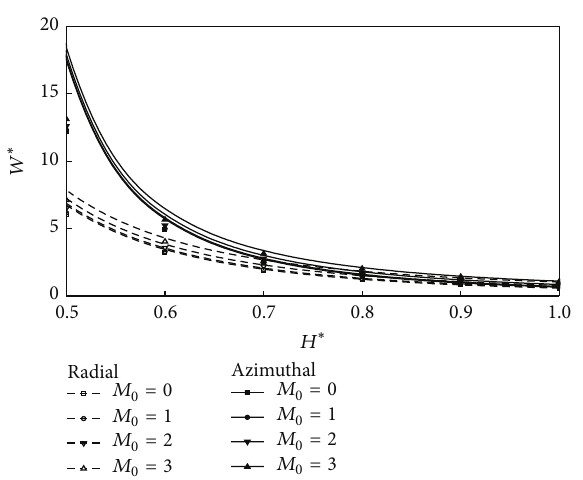
Figure 6: Variation of nondimensional load carrying capacity 𝑇 ∗ with ℎ ∗ 1 for different values of 𝑙 ∗ with 𝑀 0 = 3 and 𝑙 ∗ = 0.3 .